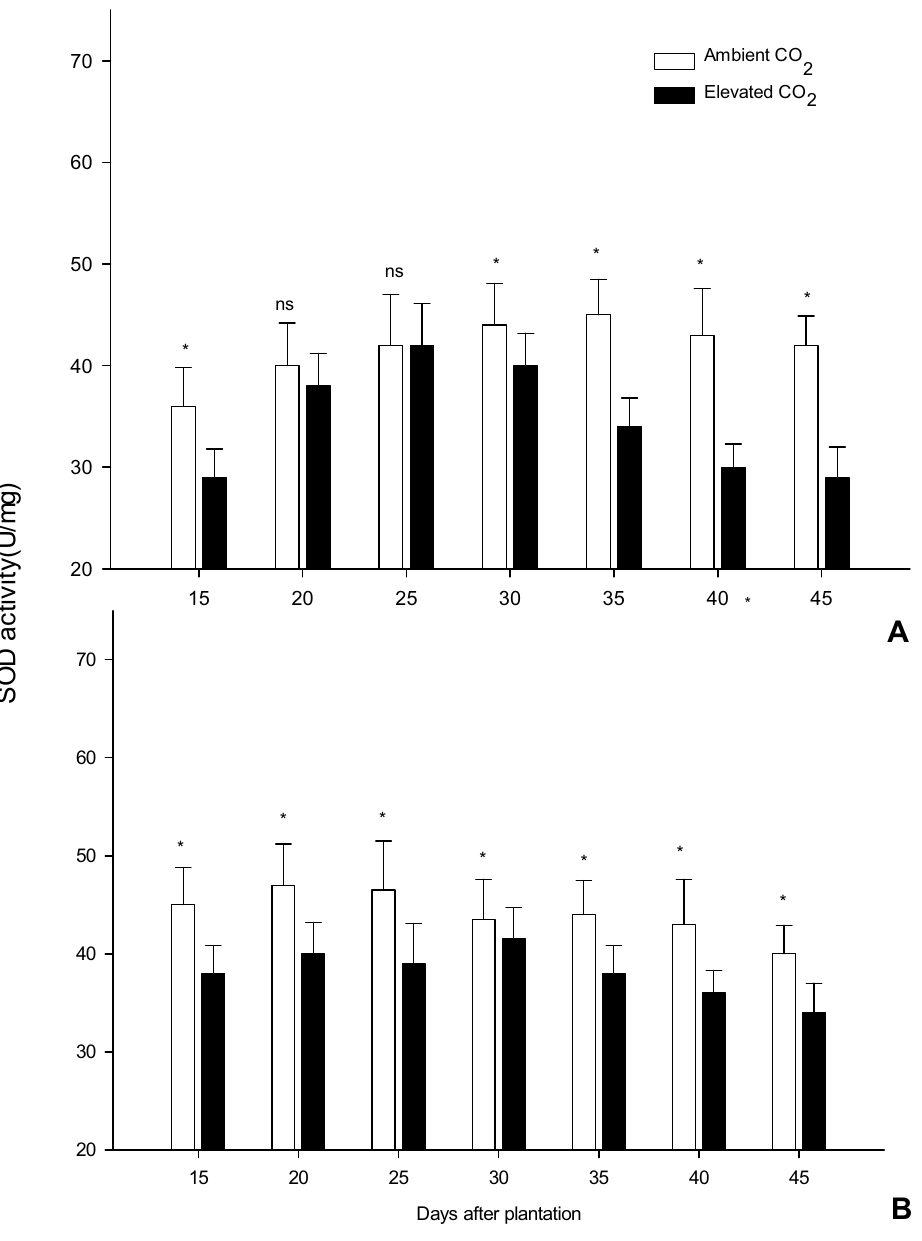
Figure 5. The Superoxide Dismutase (SOD) content in rice leaves grown in ambient and e CO 2 (Values are means ± SEM of five replications) (Mean (± SEM) followed by the symbol * in an individual experiment indicate significant difference (P < 0.05) in a Tukeys test) (ns-non